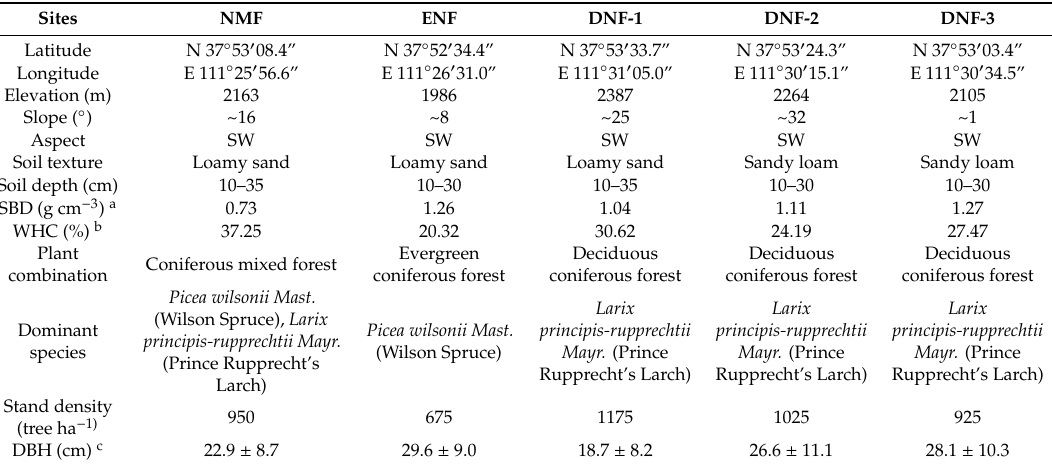
Table 1. Summary of characteristics for all five